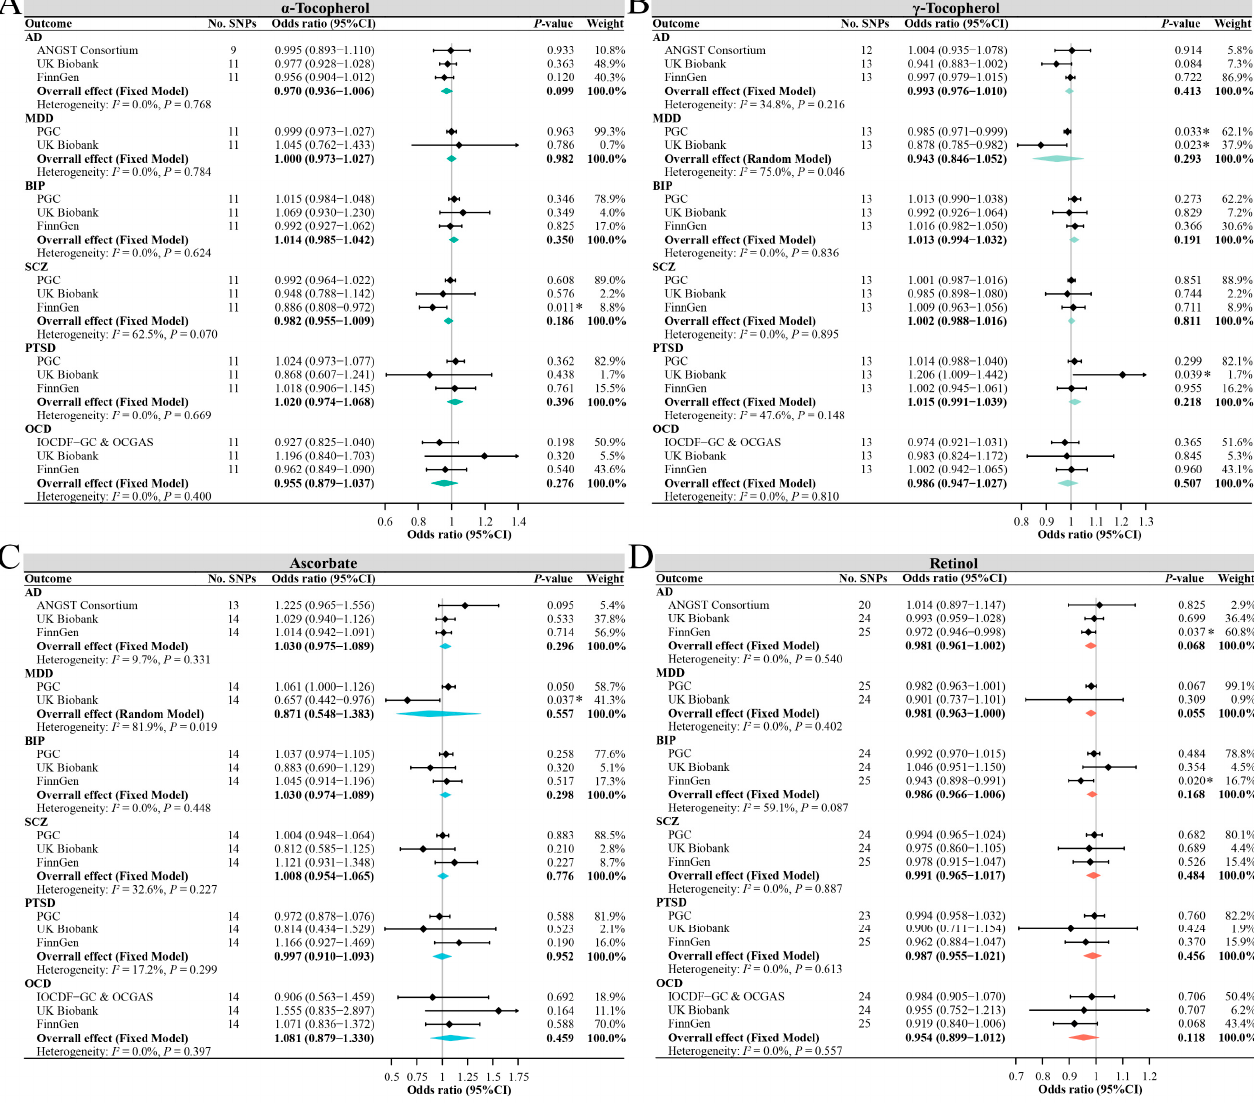
Figure 3. The main MR analysis results of the causal effects of four circulating antioxidant metabolites on six major mental disorders. The ORs are scaled per 0.1 unit increase in log-transformed α -tocopherol ( A ) and γ -tocopherol ( B ) and per unit increase in log-transformed ascorbate ( C ) and retinol ( D ). The asterisk represents a suggestive association (0.001 < p -value < 0.05). Abbreviations: AD, anxiety disorders; MDD, major depressive disorder; BIP, bipolar disorder; SCZ, schizophrenia; PTSD, post-traumatic stress disorder; OCD, obsessive–compulsive disorder.